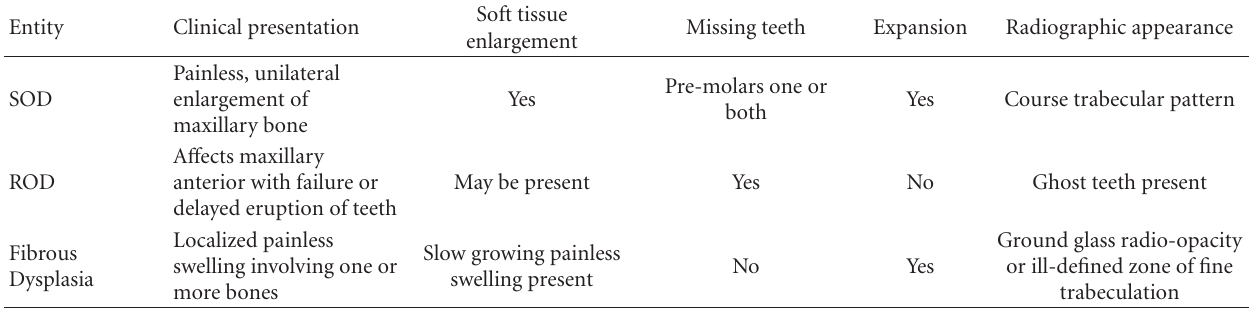
Table 3: Features to distinguish between SOD, ROD and Fibrous